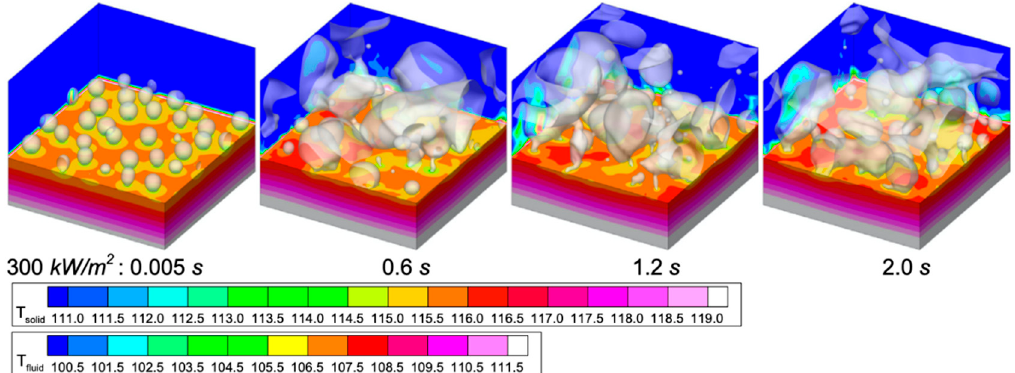
Figure 12. Simulation of the collective behaviour of steam bubbles in pool boiling [56] at a heat flux of 300 KW / m 2 , tracking the evolution of a few bubbles for two seconds until the bubbles merge and form a vapour blanket on the solid surface.